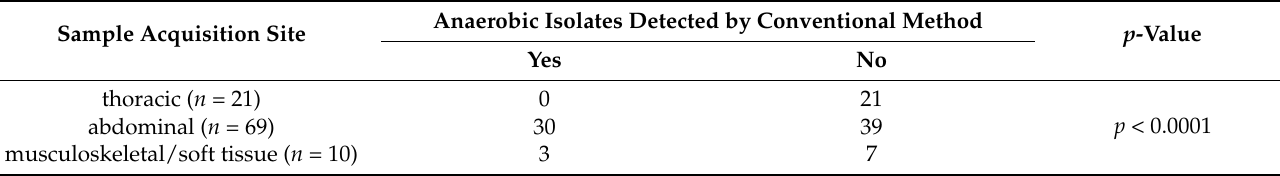
Table 6. Number of detected anaerobic species by conventional method depending on sample acquisition site. Sample Acquisition